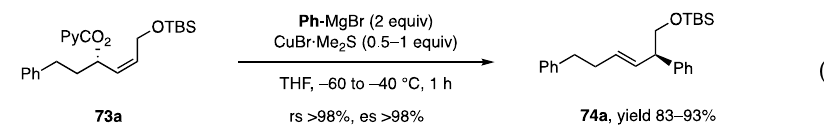
Figure 7. Biologically active compounds synthesized by using RMgX/CuCN 1 . 1 C–C bonds con- structed by the anti -S N 2 ′ reaction are indicated by a red arrow. Scheme 19. Synthesis of the active form of loxoprofen using allylic substitutions twice. 6.4. Substitution of Secondary Propargylic Phosphates A reagent system derived from Grignard reagent/copper salt was next explored for the substitution of secondary propargylic alcohol derivatives (Scheme 18, Equation (21)). Although an attempted reaction of a propargylic picolinate and PhMgBr/CuCN in THF proceeded with high regioselectivity, 10–20% of the corresponding alcohol was copro- duced. In contrast, phosphate 75a and PhMgBr (2.5 equiv)/CuCN (0.25 equiv) in THF/DME (6:1) gave products 76a (Ar = Ph) with high rs and es (Scheme 20) [32]. The use of CuCN as the catalyst and DME as the additional solvent was pivotal for producing 76b – f with high selectivity. The performance of CuBr·Me 2 S was as excellent as that of CuCN. The presence of TMS at the acetylene end was decisive for achieving the